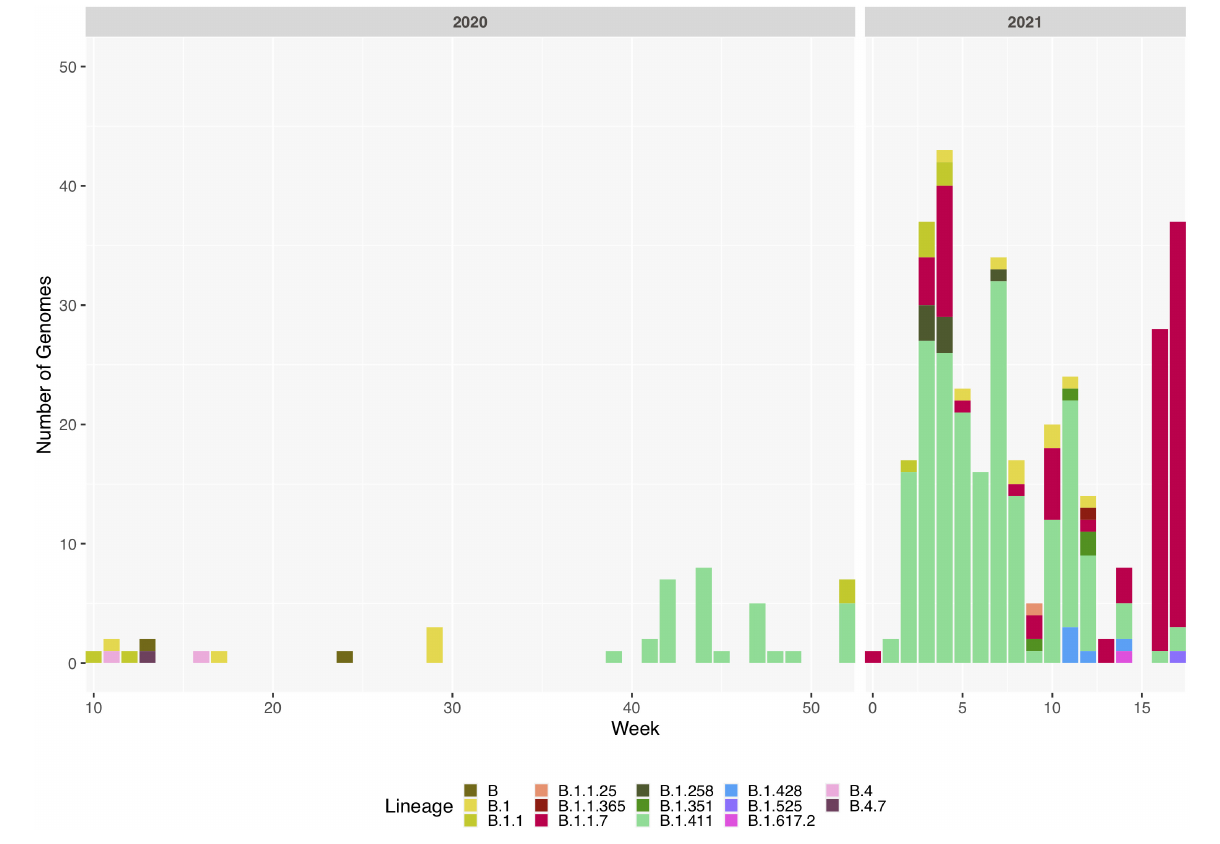
FIGURE 2 | Sri Lanka sequence lineage distribution since the detection of SARS-CoV-2 in Sri Lanka. Lineage breakdown of 373 Sri Lanka samples across time. B.1.411 was first detected in week 39 in 2020 and since B.1.411 has dominated the outbreak in Sri Lanka until week 12, 2021. B.1.1.7 was detected at the beginning of 2021 and its prevalence has rapidly increased in Sri